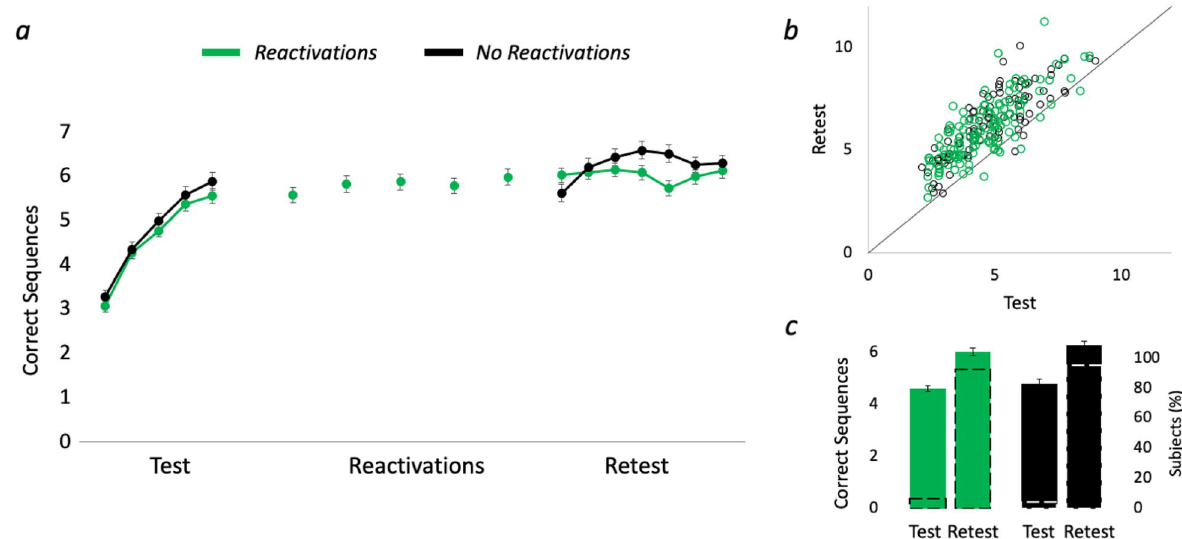
Figure 3. Micro-timescale reactivations do not induce learning. ( a ) Single-trial performance ( Reactivations group in yellow and NoReactivation group in black). ( b ) Test versus retest single-subject performance presented in a scatterplot along a unit slope line (y = x) where each point reflects a participant 11,16,30 . Data accumulating above the unit line reflect subjects who improved from test to retest, expressing learning gains, while data points below the line indicate degraded retest performance. ( c ) Colored bars reflect the mean performance in test and retest sessions (corresponding to the left y-axis), dashed black bars (corresponding to the right y-axis) reflect the percentage of participants on each side of the unit slope line in ( b ). Error bars represent